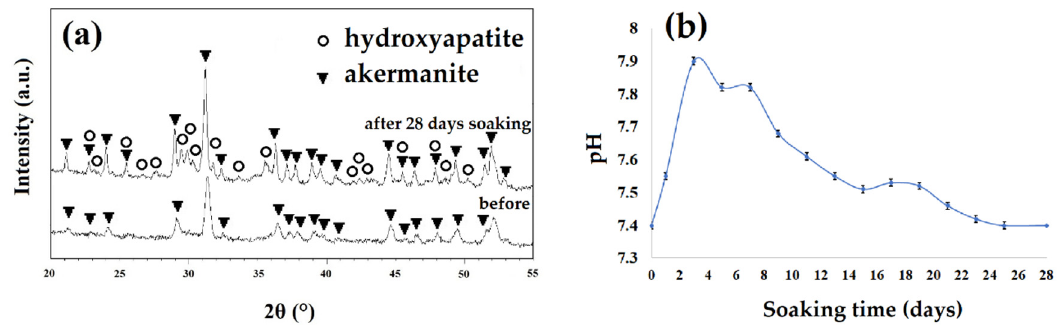
Figure 10. ( a ) The XRD patterns of the samples obtained after 20 h ball milling with subsequent annealing at 900 °C for 1 h before and after soaking in simulated body fluid (SBF) for 28 days and ( b ) the pH changes of samples as a function of time.